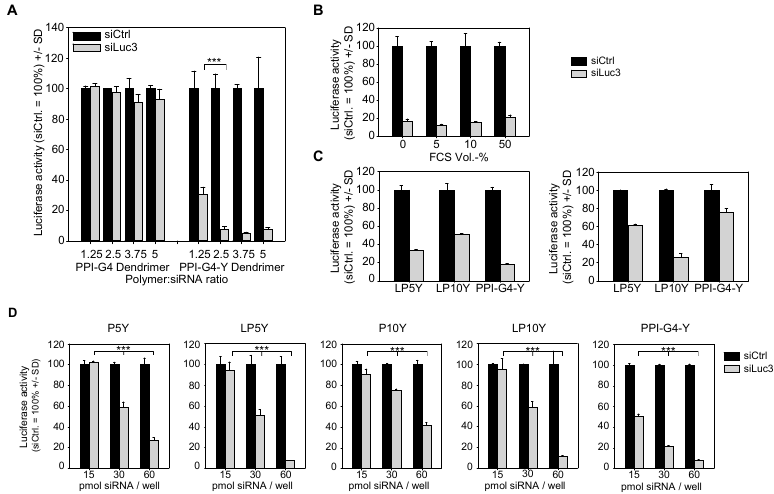
Figure 2. ( A ) Knockdown efficacies of PPI-G4 dendrimer-based siRNA complexes with (right) or without (left) tyrosine modification, as determined by luciferase knockdown in PC3-EGFP/Luc reporter cells. Bars show results upon transfection with complexes containing negative control siRNA (black) or luciferase-specific siRNA (grey), respectively, with black bars normalized to 100%. UT: untreated. ( B ) Knockdown efficacies upon pre-incubation of the complexes in the presence of FCS at various concentrations. ( C ) Knockdown efficacies of tyrosine-modified PPI- or PEI-based siRNA complexes in HT29-EGFP/Luc (upper panel) or MV4-11-EGFP/Luc cells (lower panel). ( D ) Dose- dependent knockdown efficacies of various tyrosine-modified PPI- or PEI-based siRNA complexes in HT29-EGFP/Luc cells.